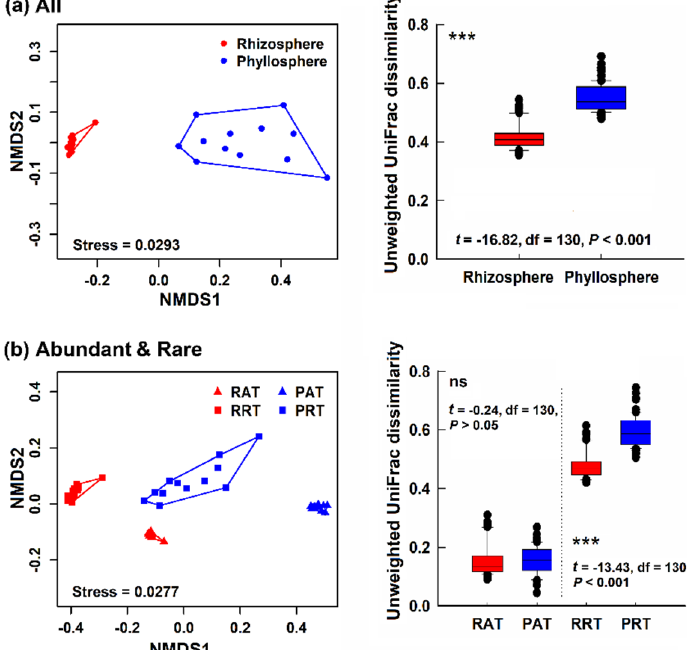
Figure 2. Comparisons of beta-diversity in different epiphytic compartments. ( a ) All, whole bacteria taxa; ( b ) Abundant & Rare, abundant bacteria taxa and rare bacteria taxa. Left, Non-metric multidimensional scaling (NMDS) ordination of bacterial communities based on unweighted Unifrac distance (phylogeny dissimilarity). Right, the pairwise unweighted Unifrac dissimilarity of bacterial communities between different epiphytic compartments. The top and bottom boundaries of each box indicate the third and first quartile values, respectively, and lines within each box represent the median values, whiskers show 95% range, and points are outliers. ***, indicate significant differences among different groups ( n = 12 for each group) (two-tailed independent-sample t -test, ***, P < 0.001; ns, no significance). RAT, rhizosphere abundant taxa; PAT, phyllosphere abundant taxa; RRT, rhizosphere rare taxa; PRT, phyllosphere rare taxa.